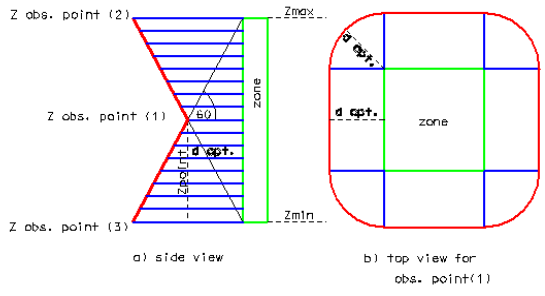
Figure 8. Optimal distance for any zone. Source: own